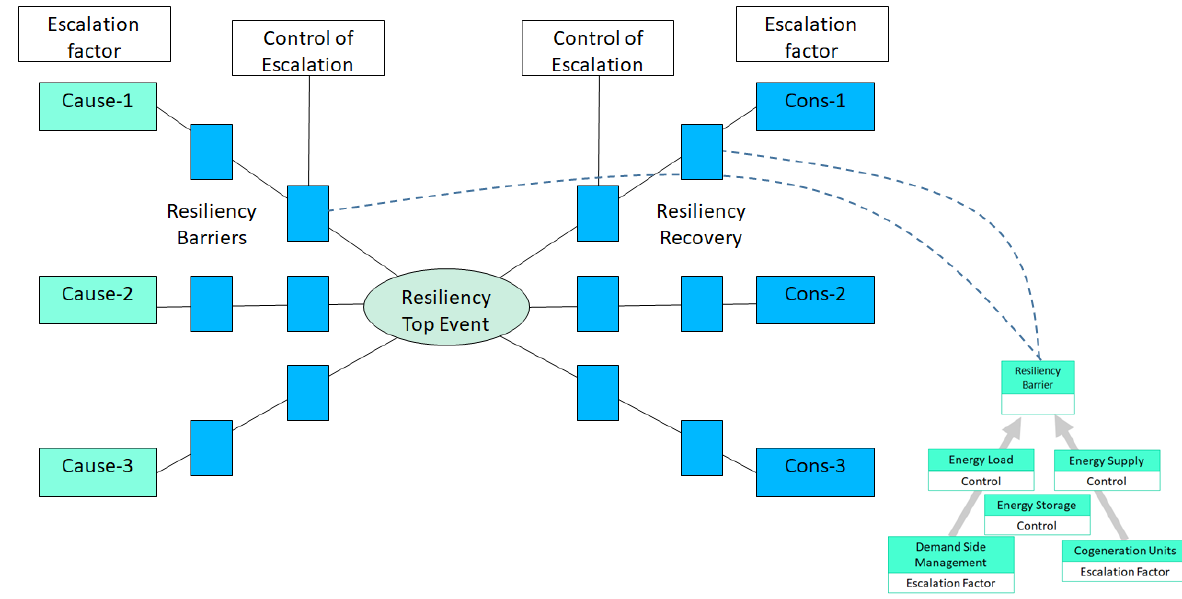
Figure 8. Resiliency propagation and control analysis.